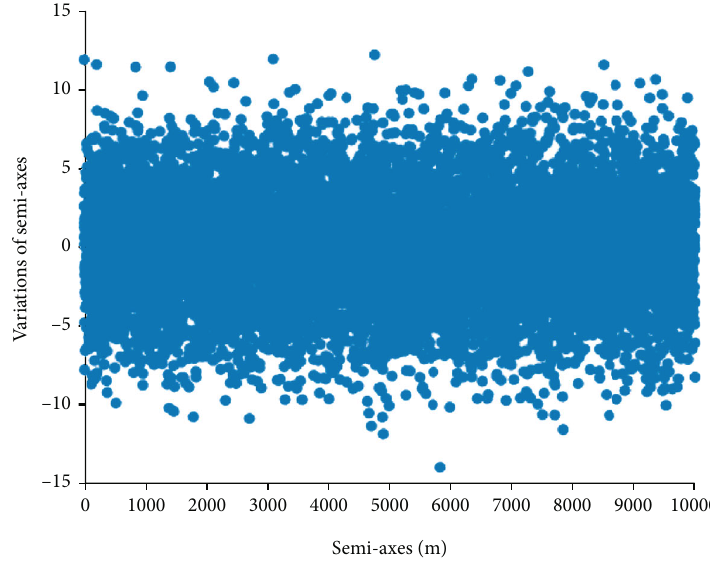
Figure 6: Normal distribution of semiaxes.